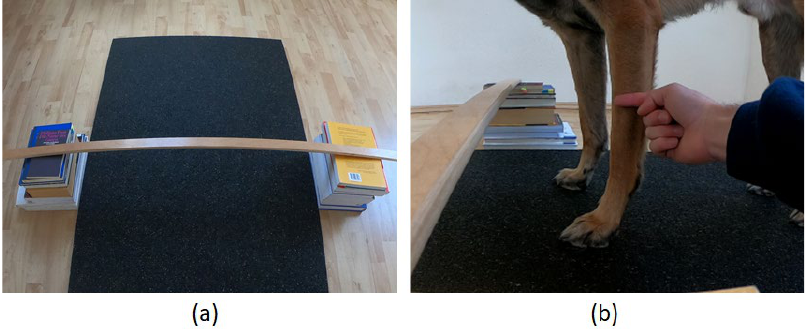
Figure 4. ( a ) Hurdle built from a slat and two piles of books. ( b ) The height of the hurdle measures half the length of the dog’s front